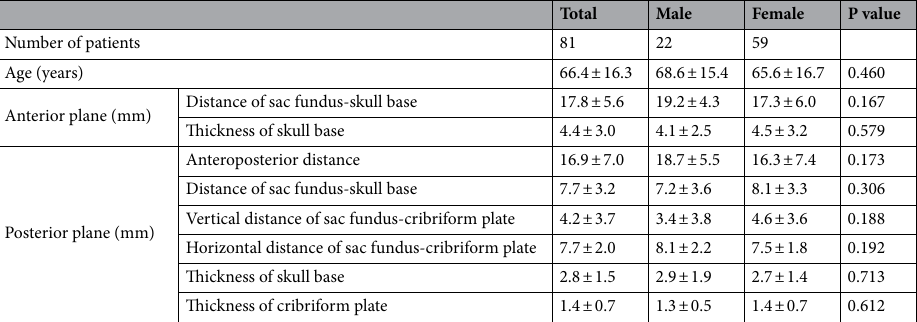
Table 2. Demographic data on patients, measurement results, and sex-related comparison in the computed tomographic study.